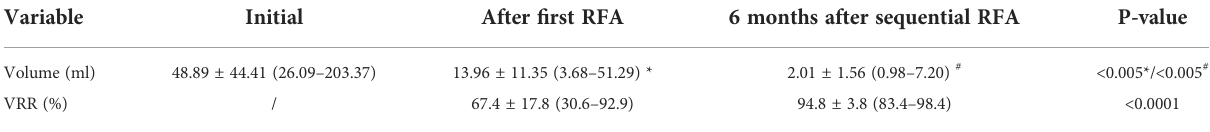
TABLE 4 The ef fi cacy of sequential RFA treatment.